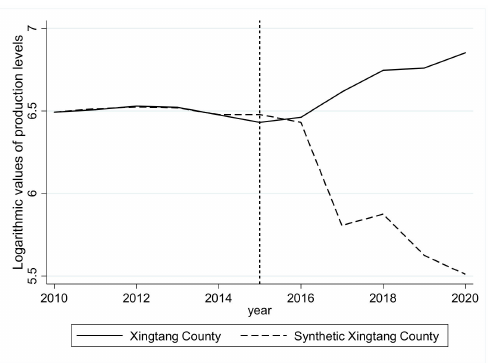
Figure 3. Effect of the CFFP on the production level of cattle industry.